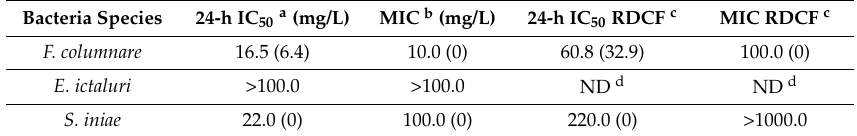
Table 1. Results of the bioassay evaluation of the crude extract from the roots of Vitis rotundifolia against fish pathogenic